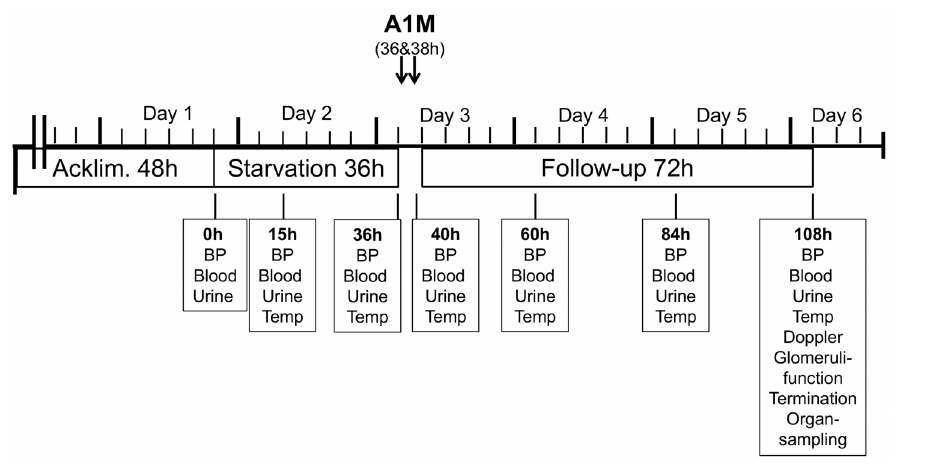
Figure 1. Overview of the experimental setup. The experiment extended over 6 days (108 hours), and the first time-point (0 h) represents the start of starvation. Pre-experimental acclimatization, starvation and follow-up were done at the time-periods shown. A1M-infusion was done twice with a 2-hour interval just before starvation end at 36 hours and 2 hours later as described in the materials and methods section. Sampling was performed at 7 time-points: 0 h, 15 h, 36 h (during starvation) and at, 40 h, 60 h, 84 h and 108 h (corresponding to 4, 24, 48 and 72 hours of the re- fed follow-up period).